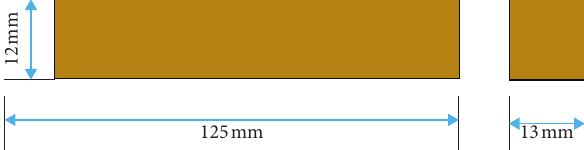
Figure 3: Specimen description for flexural test (ASTM D790 standard).